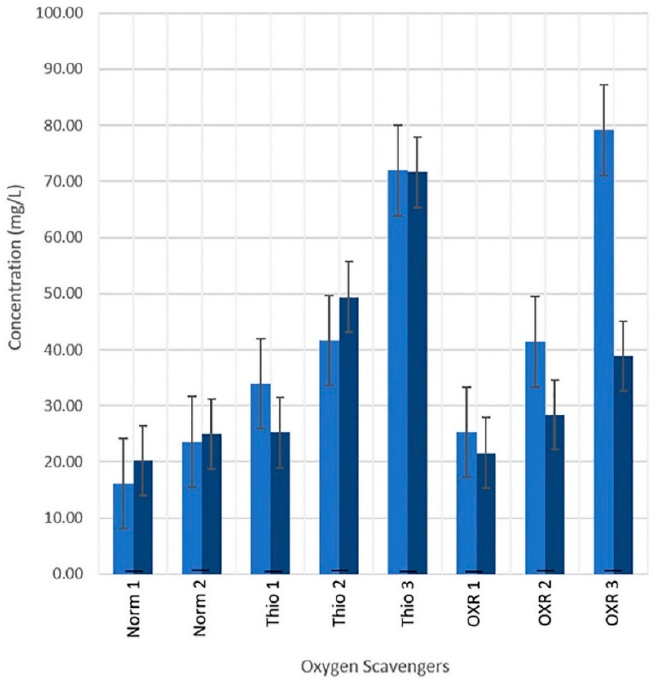
Figure 7. ICP results: iron average content with standard error bars for oxygen scavenger solutions after the first week (W1 averages, left columns) and after treatment (final averages, right columns).